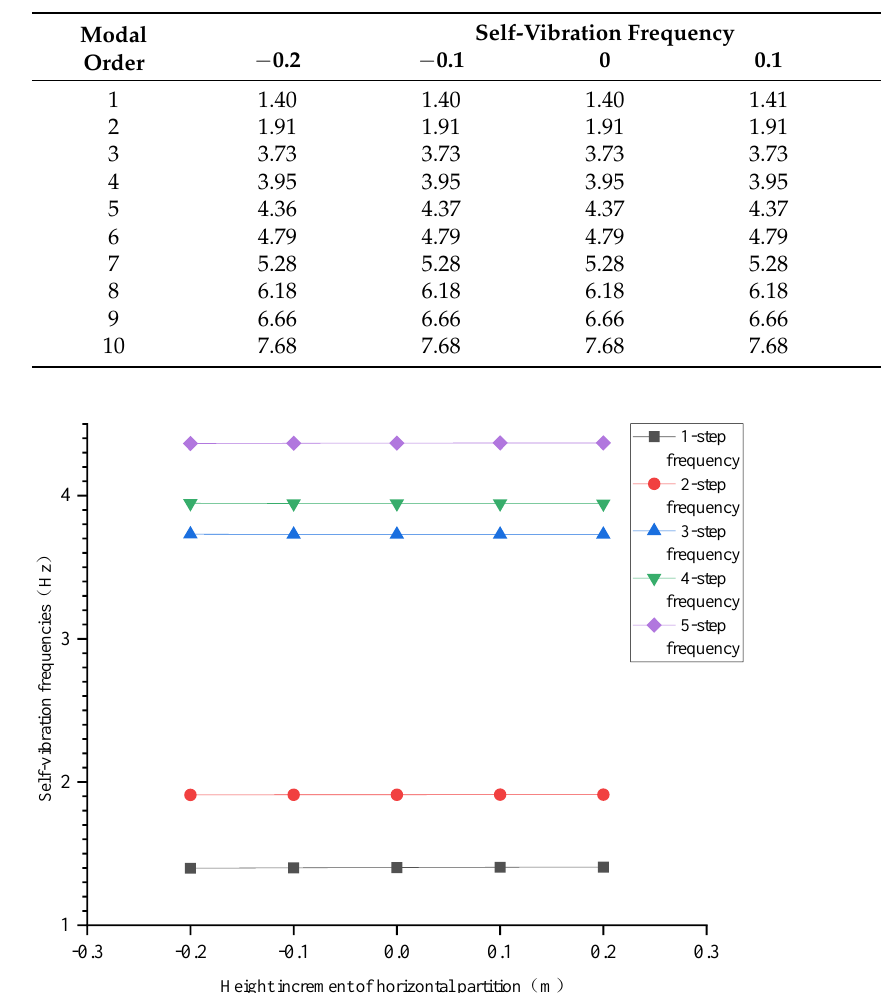
Figure 7. Self-vibration frequencies of the original structure at different beam heights.